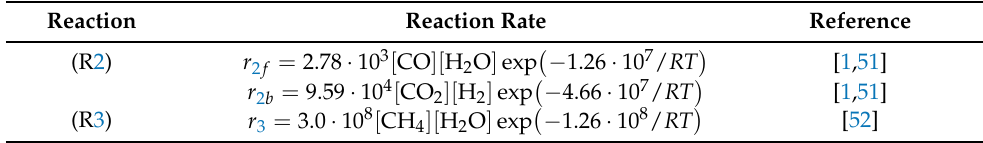
Table 2. Reactions kinetics of the homogeneous